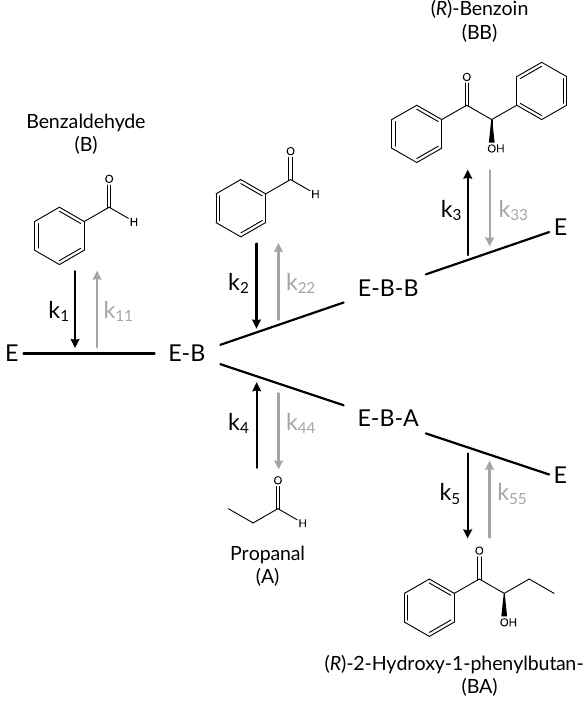
Figure 1. Branched reaction scheme for benzaldehyde lyase from Pseudomonas fluorescens ( Pf BAL) catalyzed carboligations with benzaldehyde and propanal as